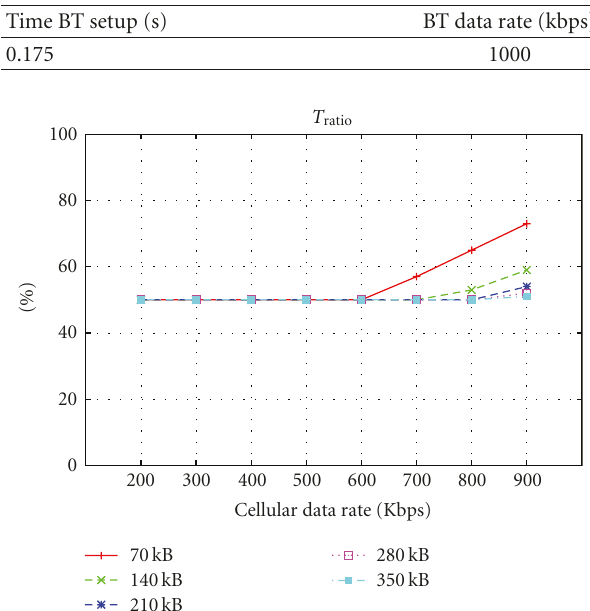
Figure 7: T ratio plotted against DR Cell for di ff erent sizes of D tot .